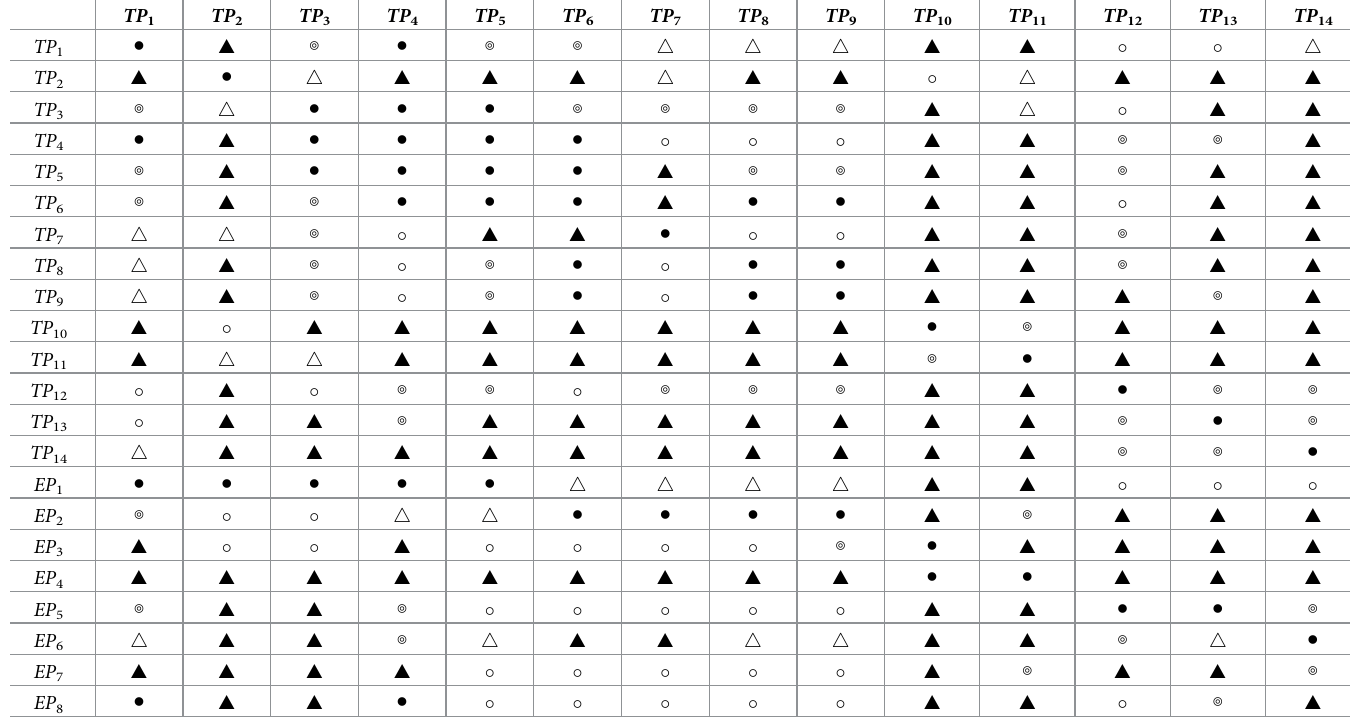
Table 9. The evaluation information in the second stage (One export).